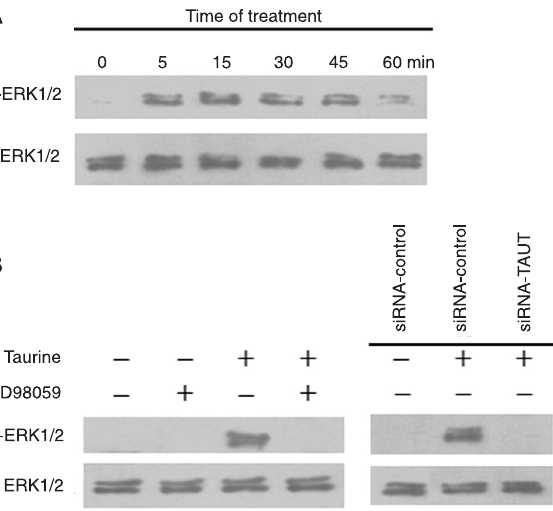
Figure 4. Effect of taurine on ERK1/2 activation in MC3T3-E1 cells. Cell lysates were subjected to Western blot using antibod- ies against p-ERK1/2 and ERK1/2. Representative results are shown. A , Cells exposed to 10 mM taurine for 5 to 60 min. B , Cells incubated with 10 μM PD98059 for 3 h prior to treatment with 10 mM taurine for 15 min. Both siRNA-control- and siRNA- TAUT-transfected cells were treated with 10 mM taurine for 15 min. ERK = extracellular signal-regulated kinase; TAUT = taurine transporter; siRNA = small interfering